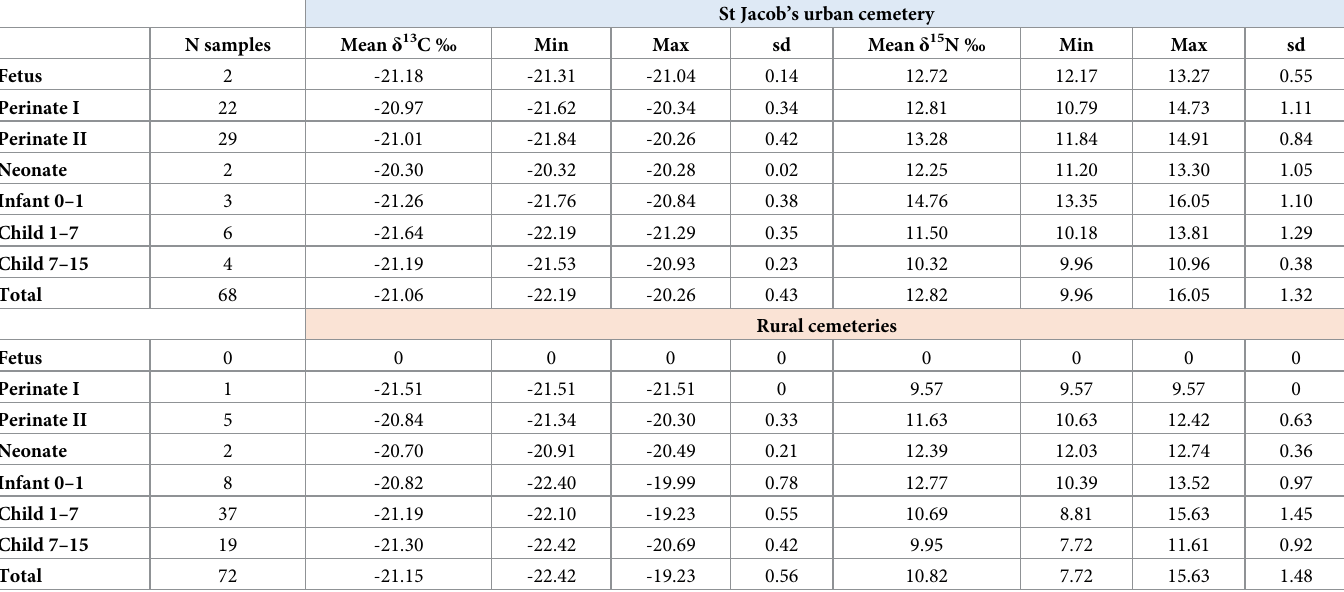
Table 2. Descriptive statistics of urban and rural non-adults for each age